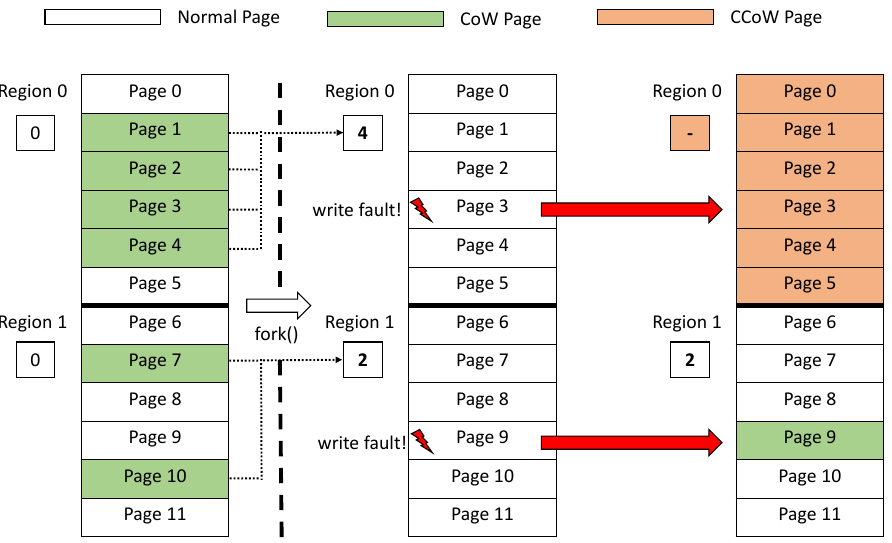
Figure 1. Processing fork and page faults with CCoW in normal